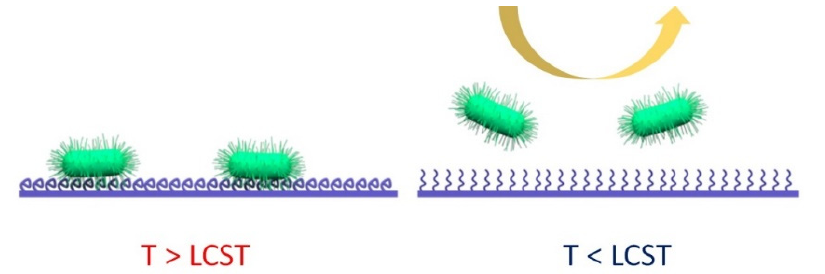
Figure 1. Surface protection using temperature-responsive polymer grafting: bacterial attachment above a lower critical solubility temperature (LCST, the polymer is in a collapsed state; left ) and bacterial removal below the LCST (the polymer is in a swollen state; right ).